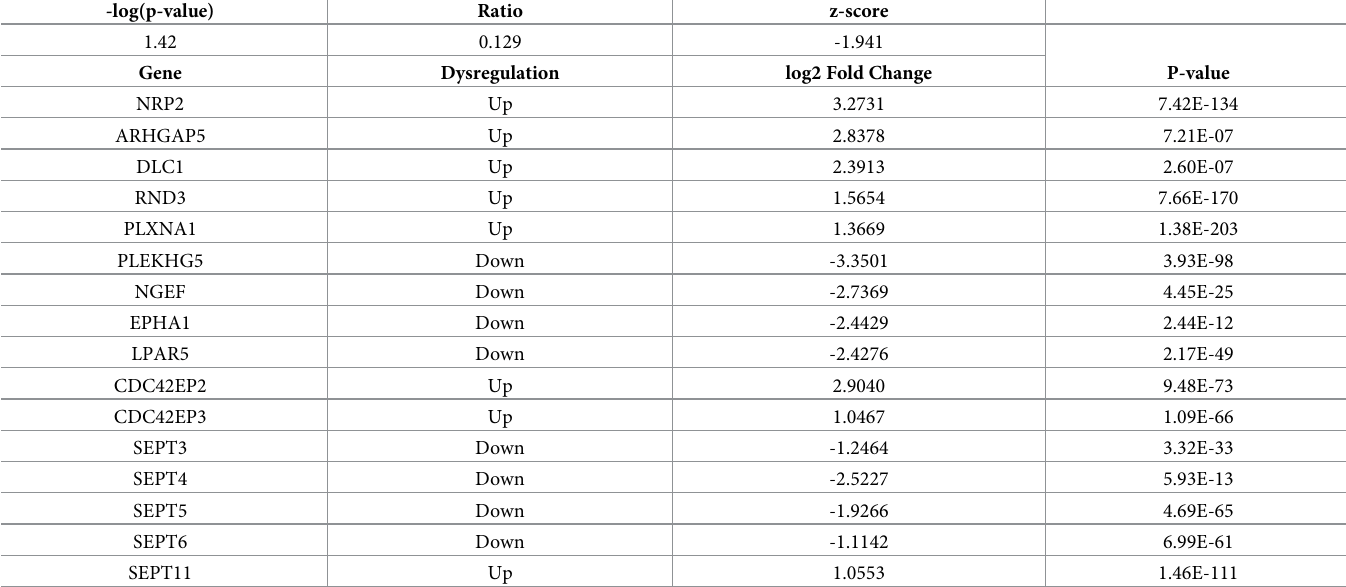
Table 3. The DEGs of RhoA signaling. According to IPA analysis on the RhoA pathway, the -log(p-value) is 1.42. The ratio refers to the number of DEGs divided by the total number of genes in the pathway. Z-score shows the likeliness of pathway activation. The value of -1.941 meant the pathway was downregulated.